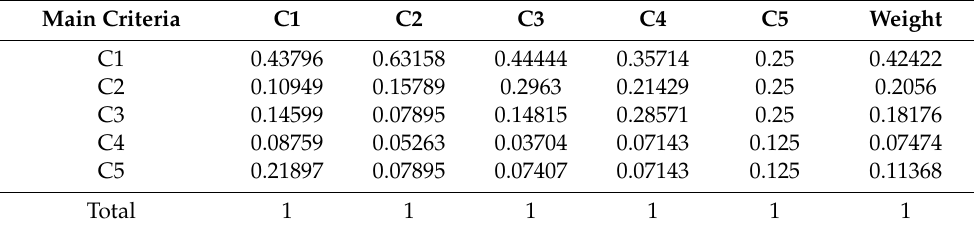
Table 6. Conversion matrix and